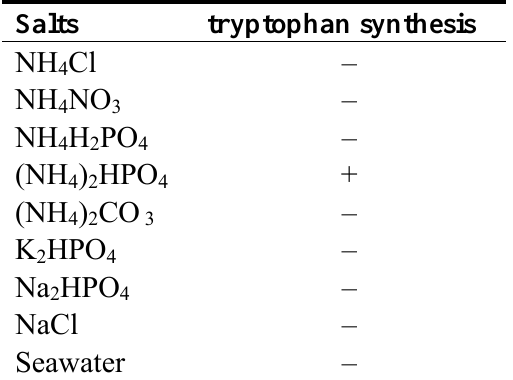
Table 1. Effects of various salts on tryptophan synthesis from D